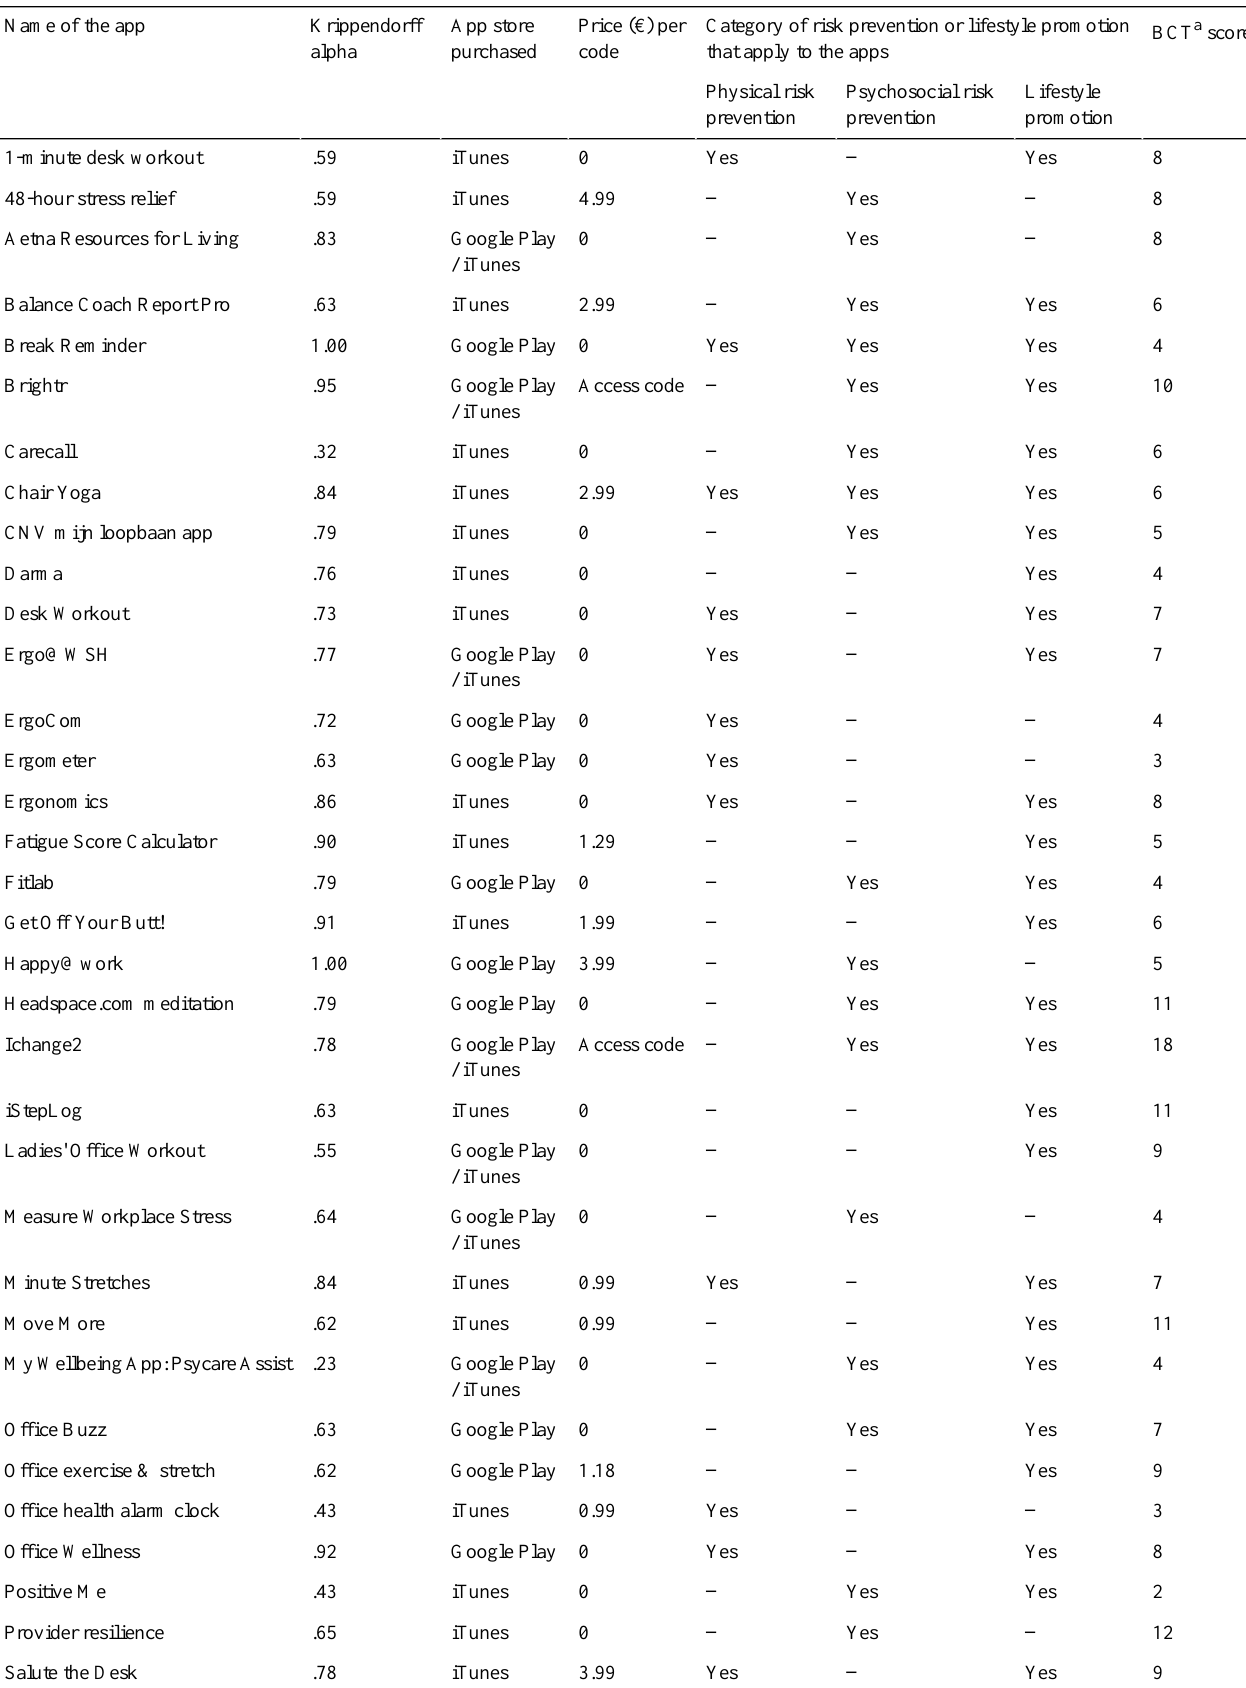
Table 1. Descriptive data of the apps that were evaluated for the presence of behavior change